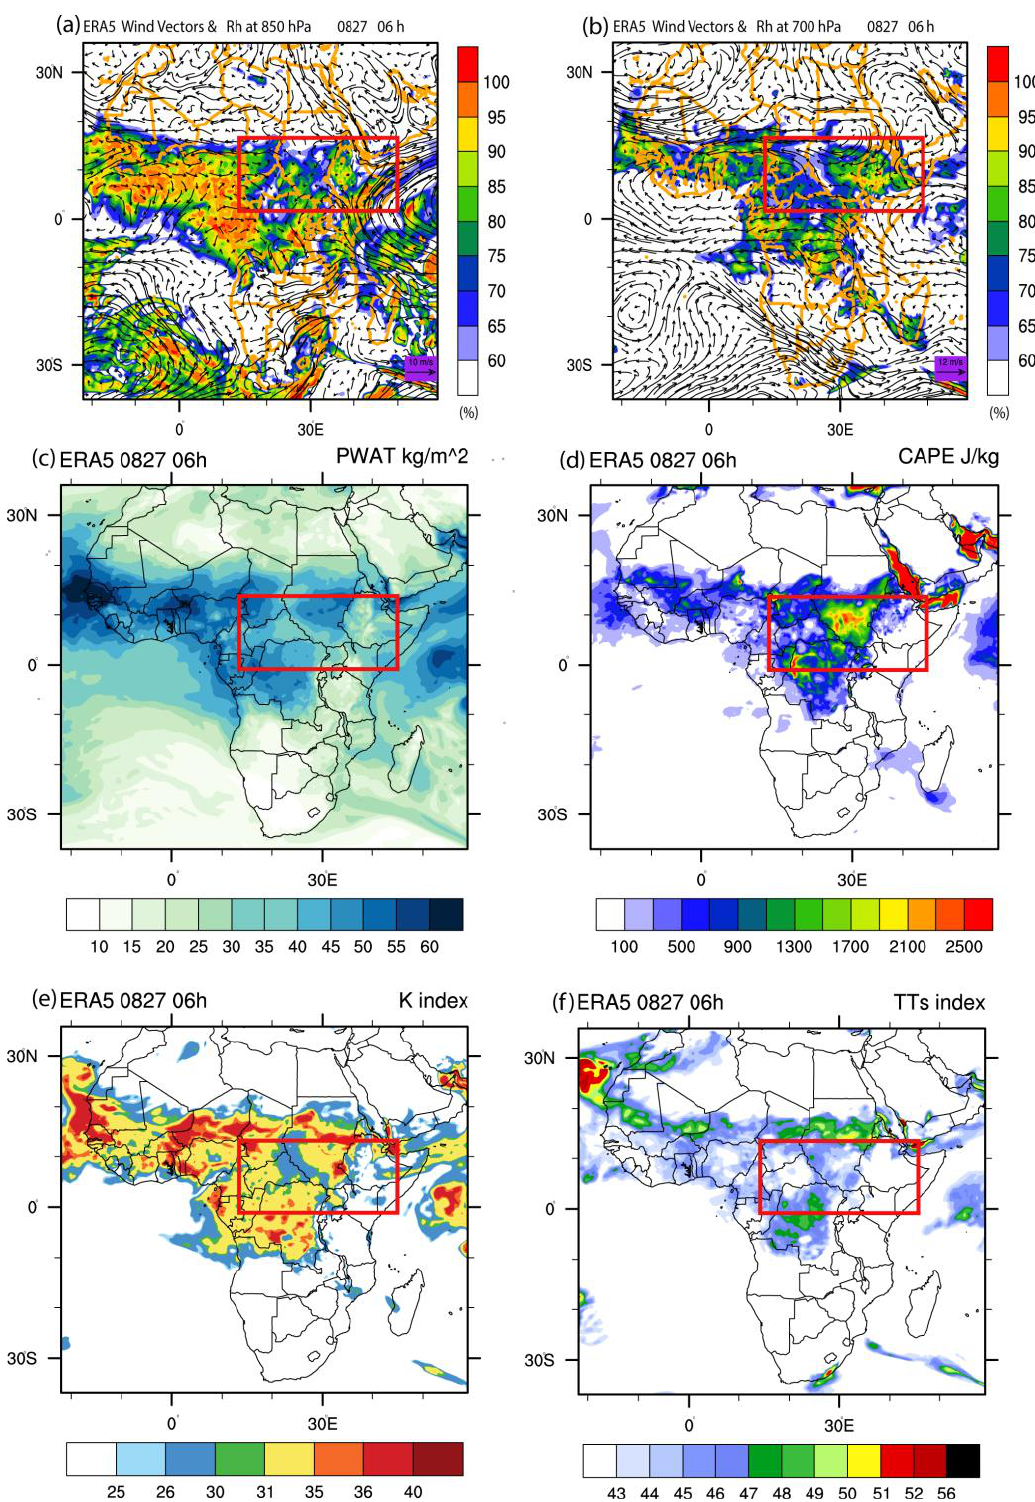
Figure 15. Synoptic analysis of ERA5 data at 6 a.m. (UTC) on 27 June 2020. ( a ) wind at 10 m (m/s; vectors) and relative humidity (%; shaded) at 850 hPa; ( b ) wind (m/s; vectors) and relative humidity (%, shaded) at 700 hPa; ( c ) precipitable water (kg/m 2 ); ( d ) convective available potential energy (J/kg); ( e ) K-index; and ( f ) total of totals index. The red box denotes the ROI (Sudan, South Sudan, Ethiopia, Uganda, and northwestern